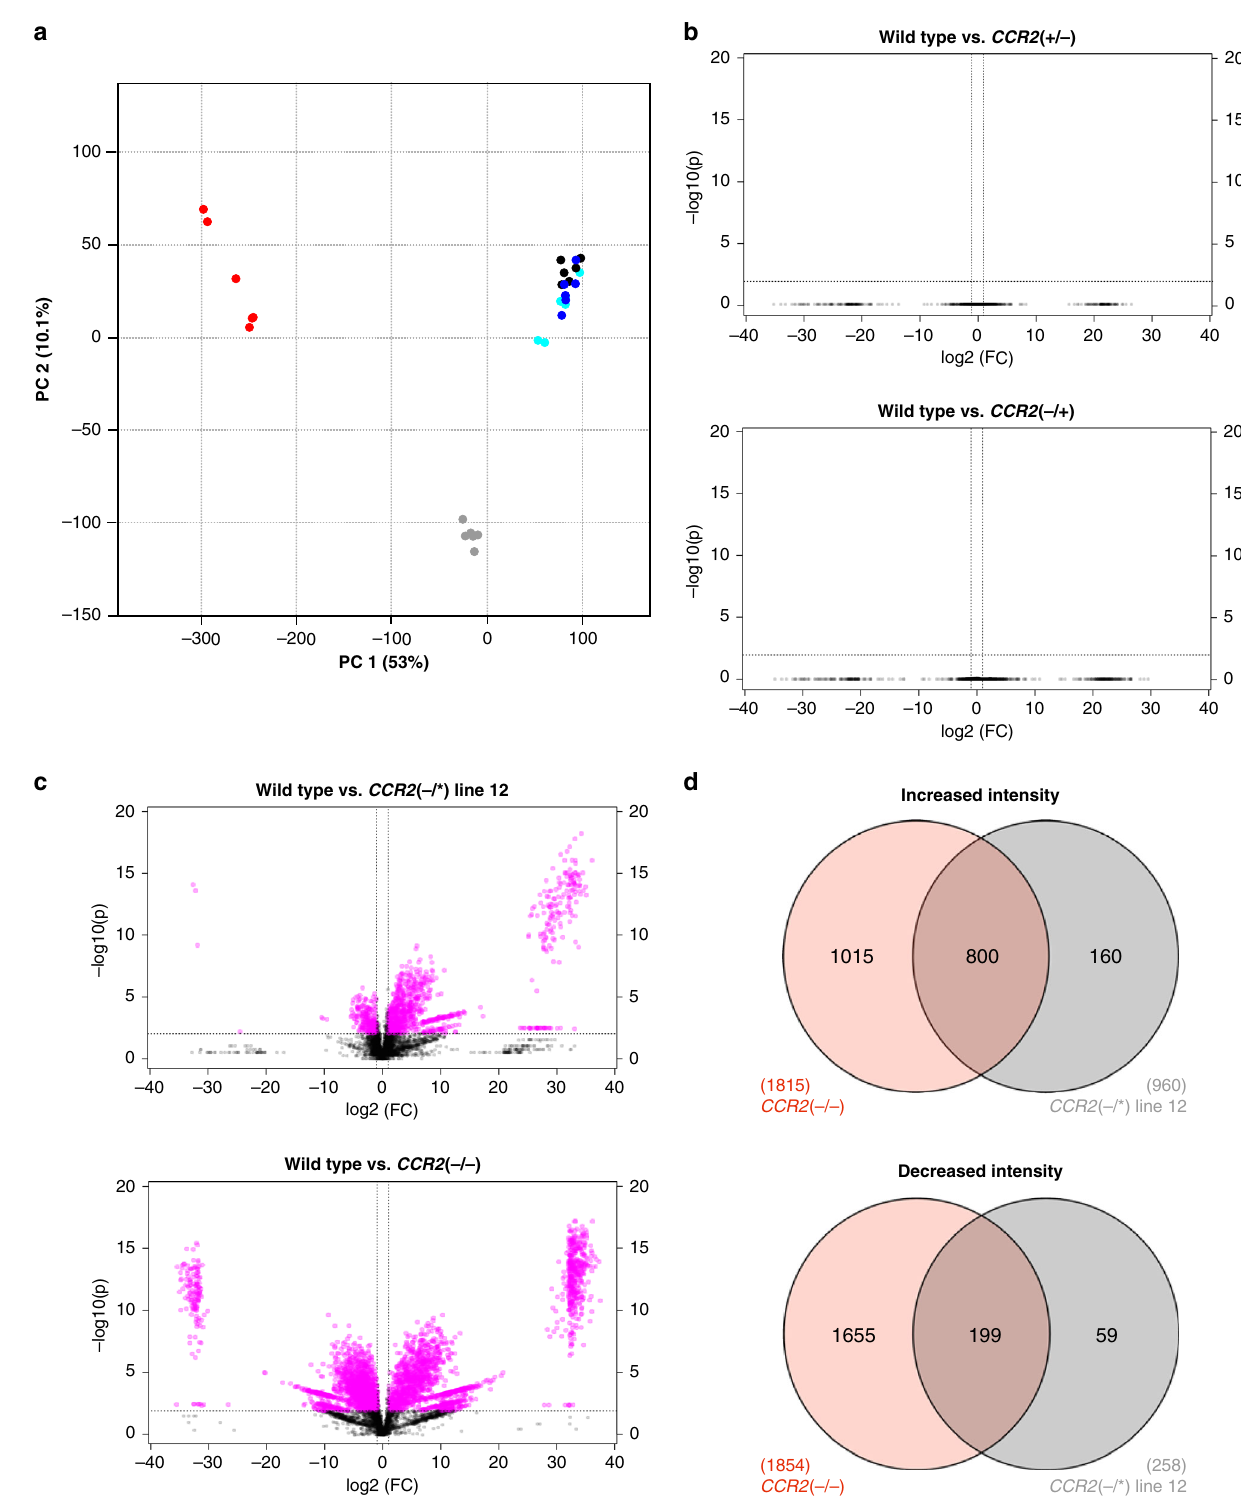
Fig. 7 Phenolic pro fi ling of CCR2 ( + / − ), CCR2 ( − / + ), CCR 2( − /*) line 12, and CCR2 ( − / − ) stems. Plants were grown for 11 weeks in the greenhouse. a Plot of principal component 1 (PC1) and PC2 of principal component analysis (PCA) on 6182 peaks. Black dots, wild type; blue dots, CCR2 ( + / − ); cyan dots, CCR2 ( − / + ); gray dots, CCR2 ( − /*) line 12; red dots, CCR2 ( − / − ). b , c Volcano plots visualizing the differences between b wild type and CCR2 ( + / − ) or CCR2 ( − / + ), and c wild type and CCR2 ( − /*) line 12 or CCR2 ( − / − ). Magenta and black dots represent peaks that are different and not different in intensity, respectively, based on the fi lters: fold change (FC) > 2 and P value <0.01 (one - way ANOVA with Dunnett ’ s post hoc test). d Venn diagrams of the number of peaks with signi fi cantly differential intensities (magenta dots from the volcano plots in ( c )) between wild type and either CCR2 ( − /*) line 12 or CCR2 ( − / − ). Wild type, n = 6 biologically independent samples; CCR2 ( − /*) line 12, n = 6 biologically independent samples; CCR2 ( − / − ), n = 5 biologically independent